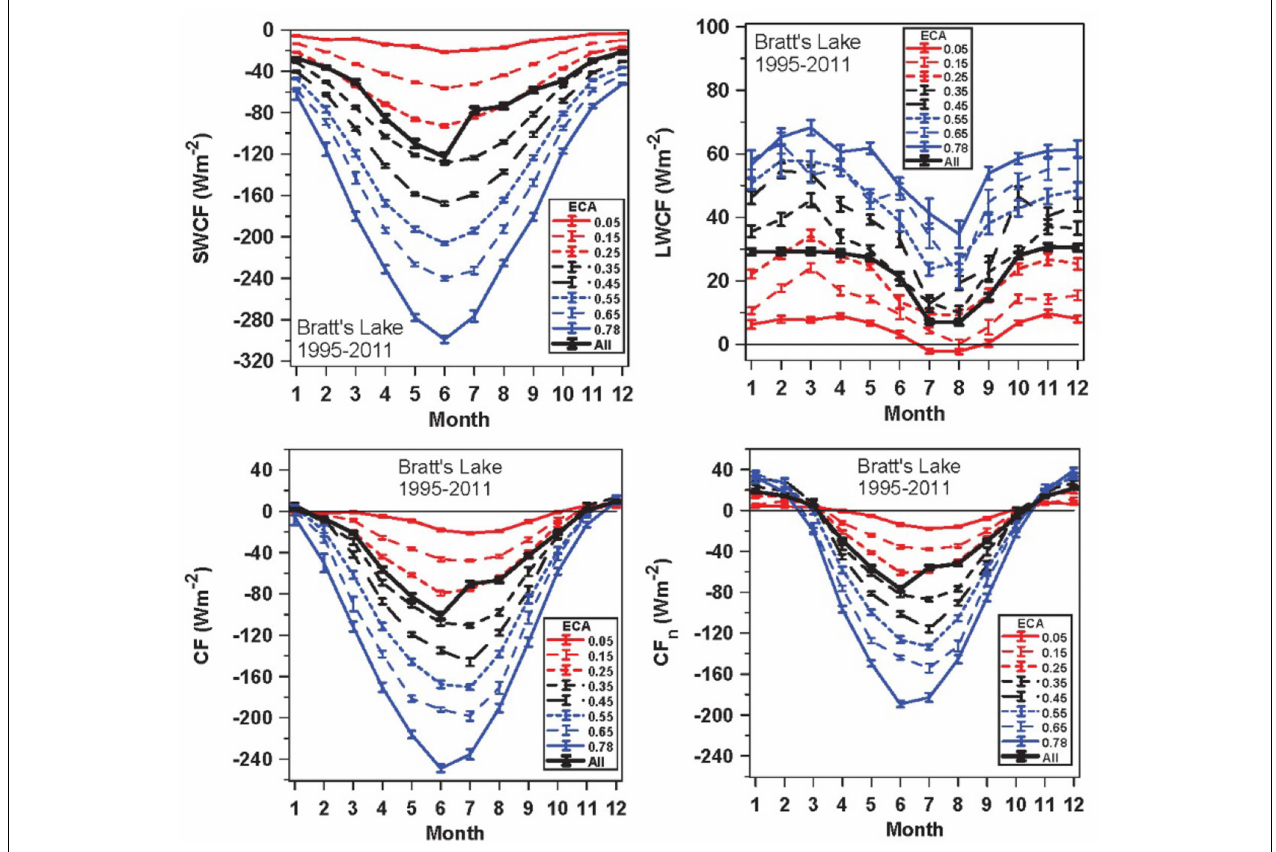
FIGURE 3 | Mean annual cycle of SWCF, LWCF, CF, and CF n , stratified by